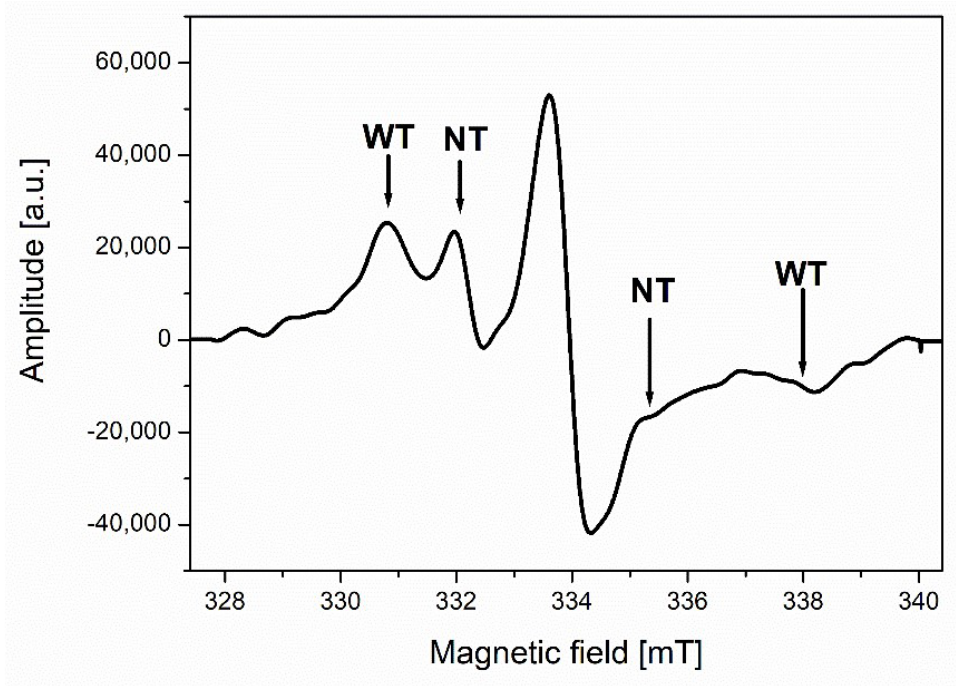
Figure 12. ESR spectrum (240 K) of TEMPO spin probe (WT: wide triplet, NT: narrow triplet) measured directly after adding HL-60 leukemia cells suspension (2.4 × 10 5 cells/mL).